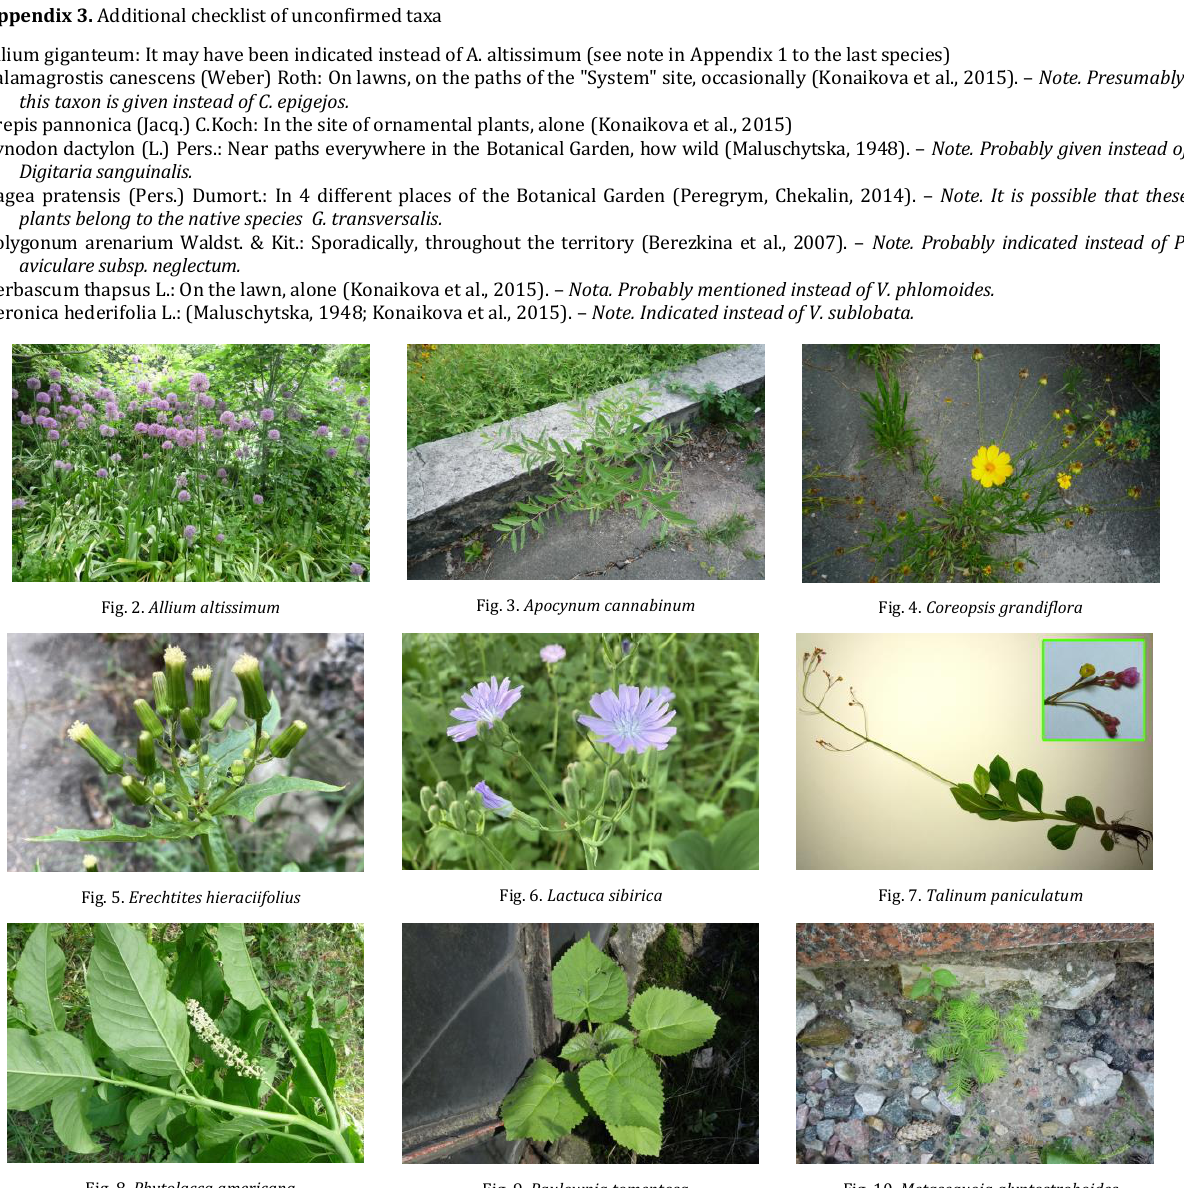
Fig. 8. Phytolacca americana Fig. 9. Paulownia tomentosa Fig. 10. Metasequoia